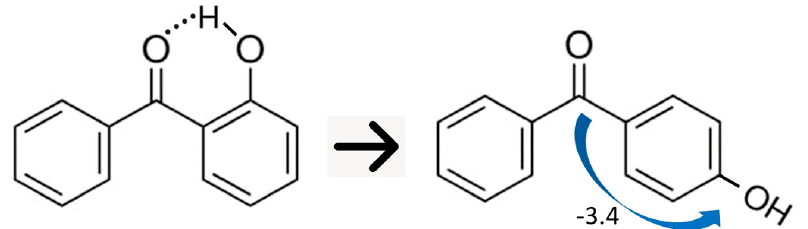
Figure 10. Determination of the intra ‐ molecular hydrogen bonding strength in 2 ‐ hydroxy ‐ benzo ‐ phenone using the “ortho ‐ para” method. The blue arrow represents the additional para C = O ( C 6 H 5 ) − OH = − 3.4 kJ.mol − 1 , that should be subtracted from the enthalpy of this reaction to attribute the corrected result to intra ‐ HB strength.